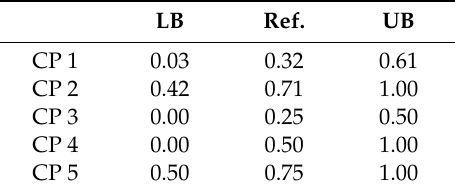
Table 2. Ranges of design